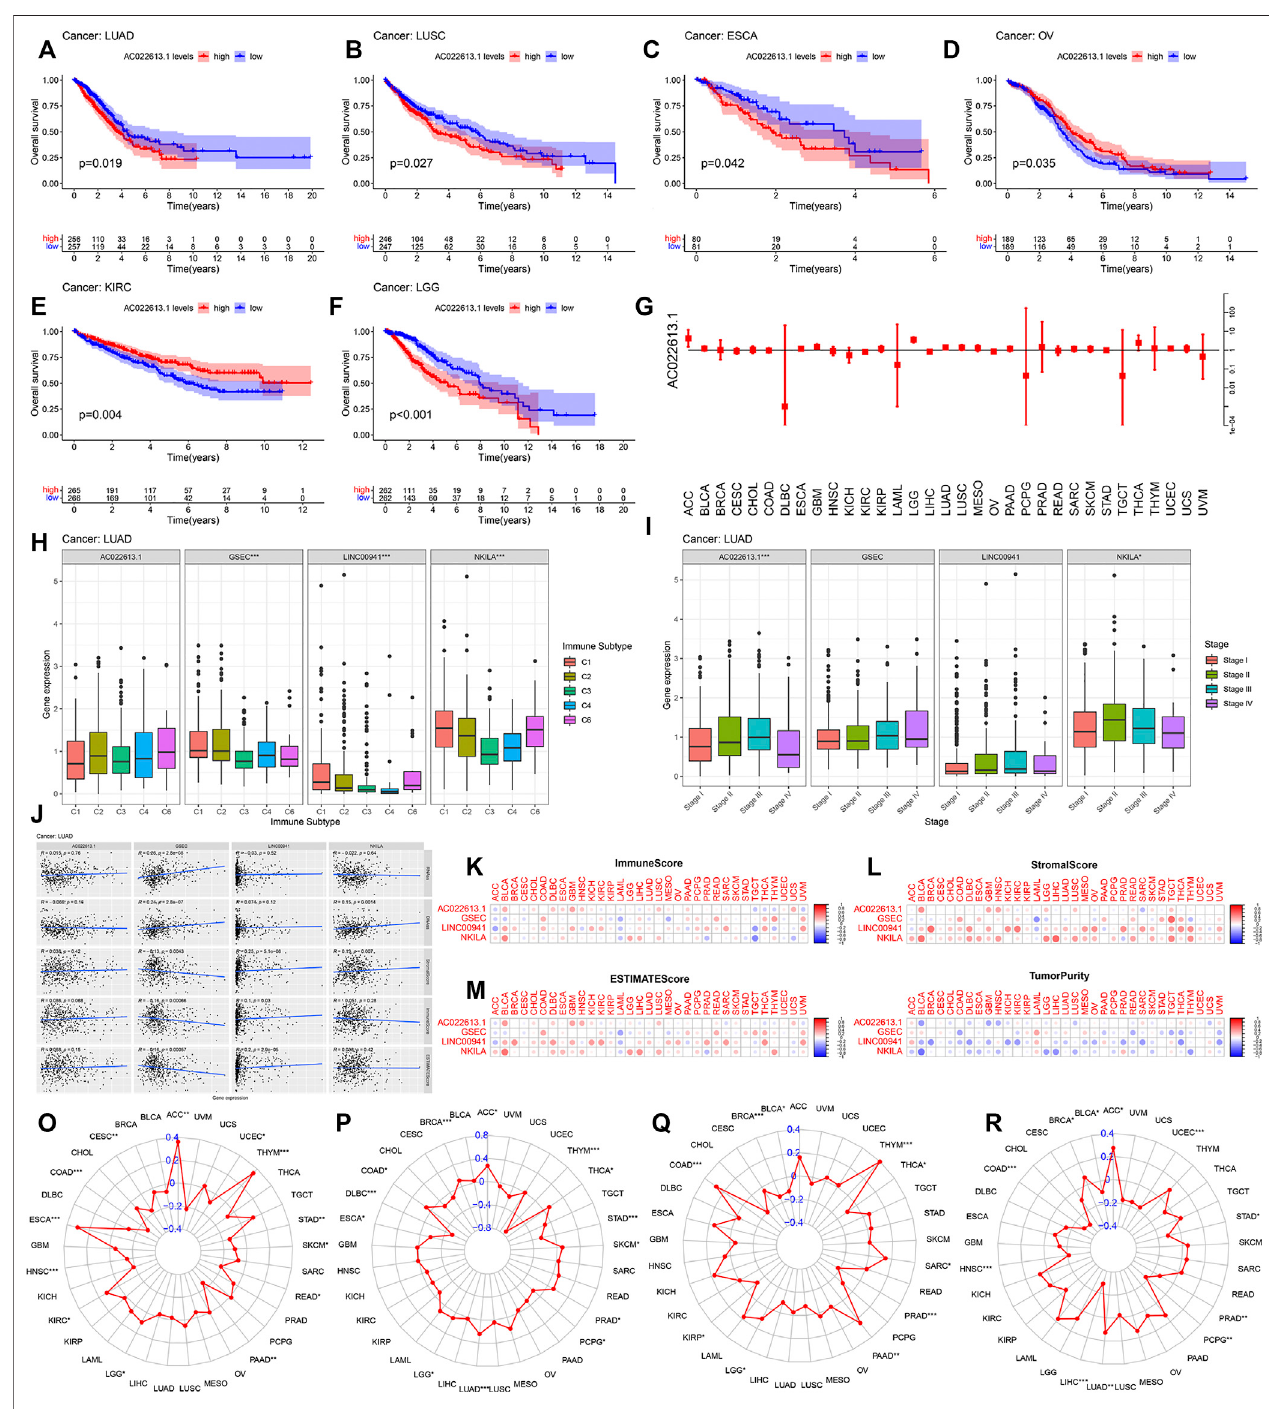
FIGURE 10 | Correlation analysis between the four lncRNAs and patient prognosis and TMB in all cancer types. (A – F) Connection of the four lncRNAs with the prognosis of patients in pan-cancer. (G) Forest plot showing the hazard ratio ofAC022613.1 across all cancer types. The correlation between the four lncRNAs and (H) immunesubtypesand (I) clinicalstageofLUAD. (J) AssociationoffourlncRNAswithtumorstemcellscoresandstromal,immune,andESTIMATEscorebySpearman ’ s correlationanalysis. (K – N) Thecorrelationrelationship betweenfour lncRNAs and stromal,immune,ESTIMATE, and tumor purityscore.In33TCGA cancertypes, the radar graph showing the associationof the expression of (O) AC022613.1, (P) GSEC, (Q) LINC00941, and (R) NKILA with TMB. p < 0.05, p < 0.01, and p < 0.0001 were represented by *, **, and ***, respectively.